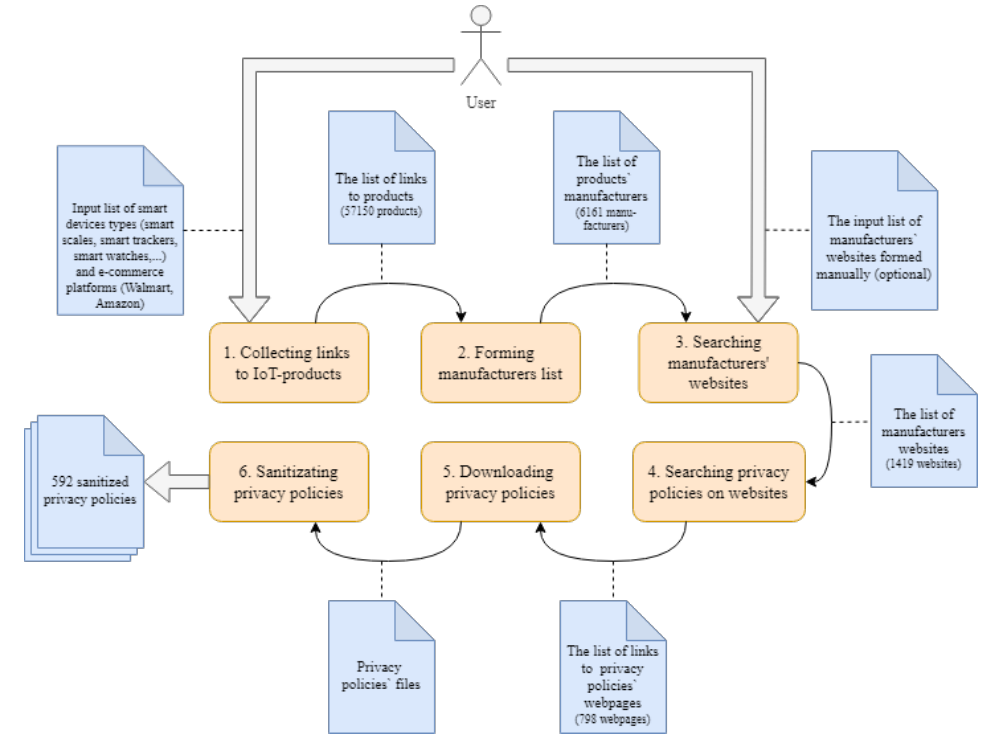
Figure 1. The scheme of the dataset generation